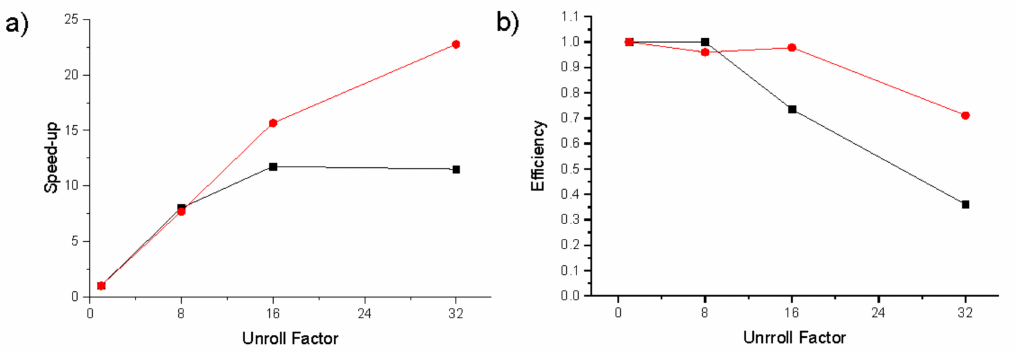
Figure 5. ( a ) Speed-up as a function of unroll factor for kernels with 16-bit (red circles) and 32-bit (black squares) transmission. ( b ) Efficiency as a function of unroll factor for kernels with 16-bit (red circles) and 32-bit (black squares)